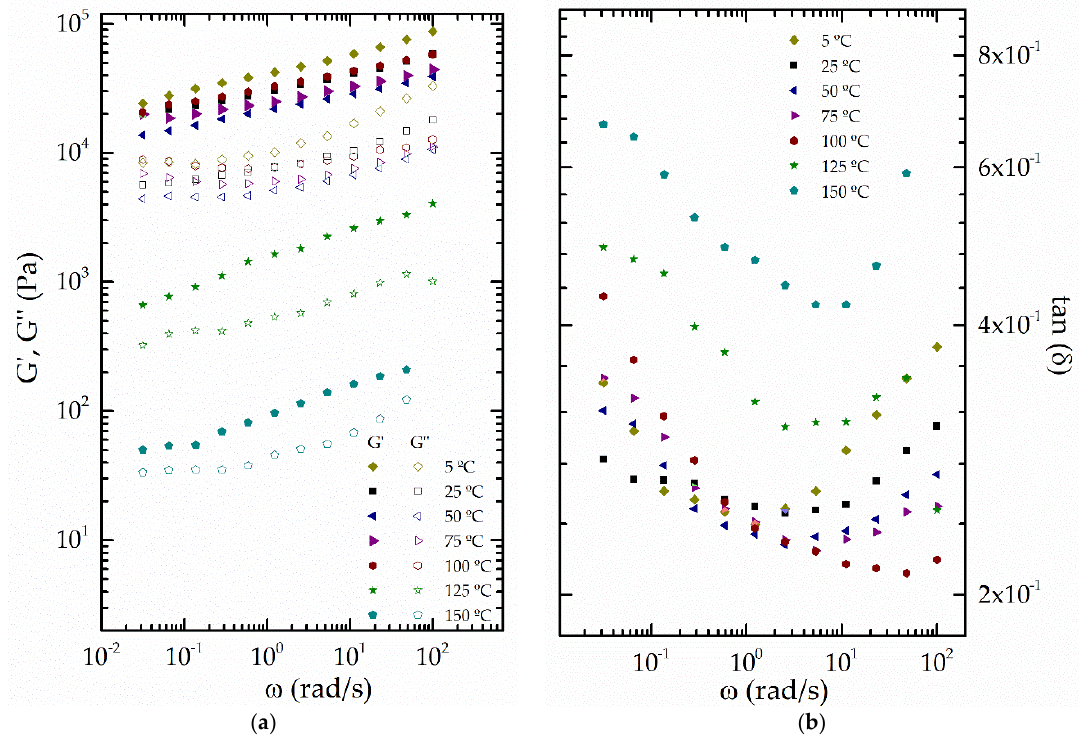
Figure 7. Frequency dependence of the storage and loss moduli ( a ) and the loss tangent ( b ) for a selected epoxidized lignin-based oleogel (EAL1 at 5 wt %) as a function of temperature ( G ′ , filled symbols; G ″ , empty symbols).